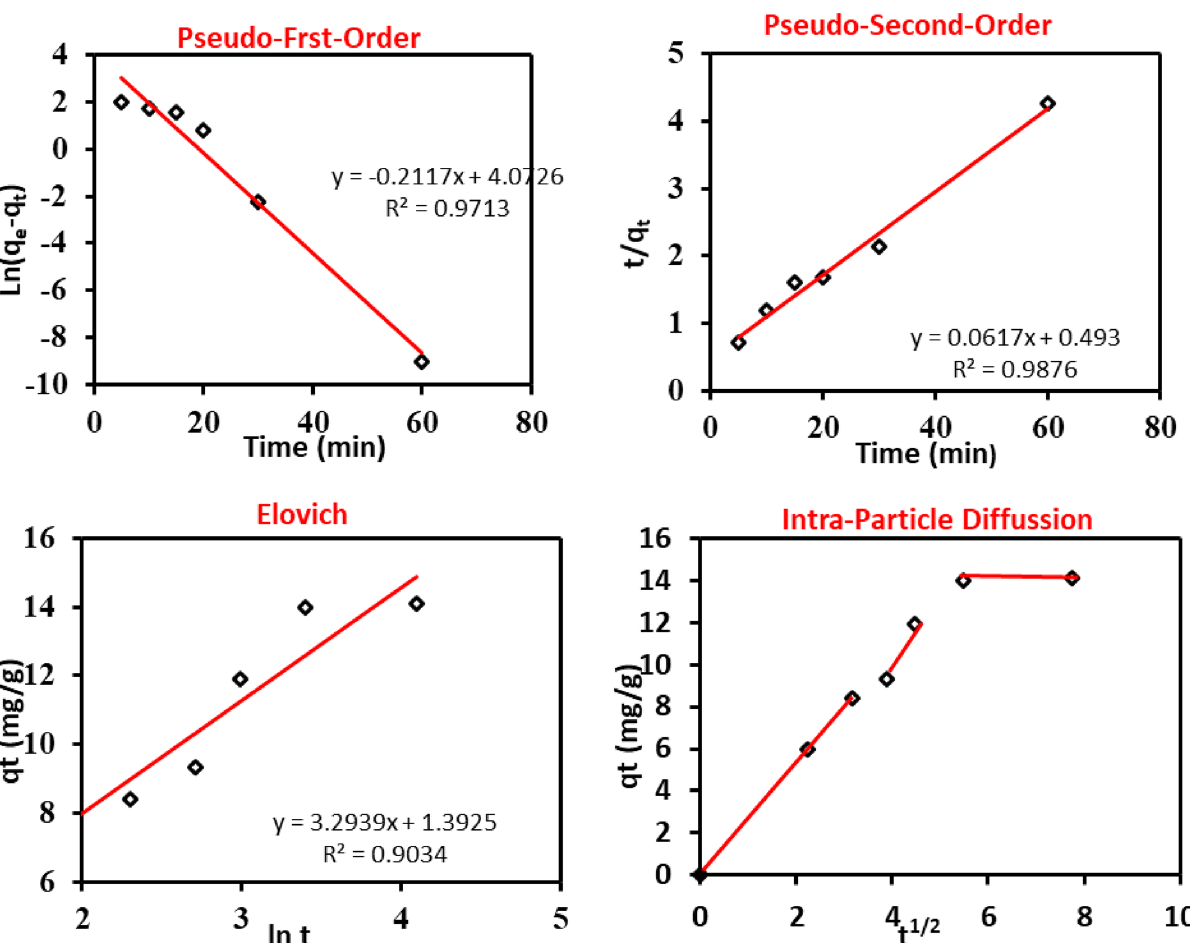
Figure 6. The different kinetic models that were applied on MB biosorption onto the prepared P. alcaliphila NEWG-2